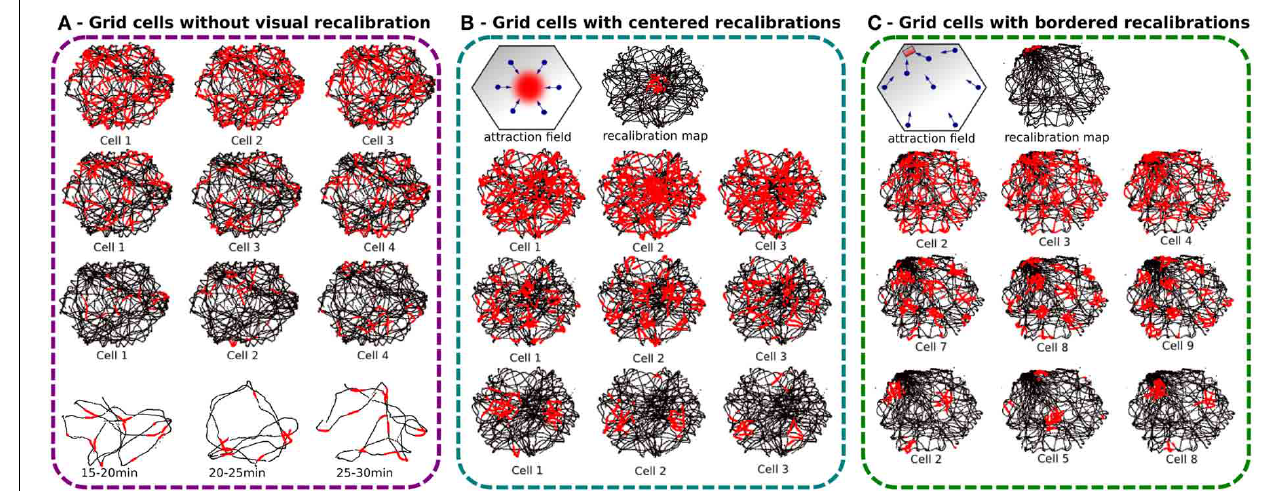
FIGURE 7 | Experiments made with a real robot randomly moving in an hexagonal enclosure during 30 min. Robot paths are shown in black, with superimposed single grid cell activity in red. (A) Grid cell activity obtained with our neural model without any recalibration (Experiment 1). Top, result of 30 min of navigation without recalibration for 3 different modulo [projection of 60 neurons on, respectively 4 (top), 9 (middle), and 25 neurons (bottom)]. We show 3 randomly chosen cells for each modulo. Activity fields are blurred due to path integration errors. Bottom, 5 min slices of time allow to show periodic firing field. (B) Same experiment but with a periodic calibration in the center every minute (Experiment 3a). The origin of the path integration is set in the center of